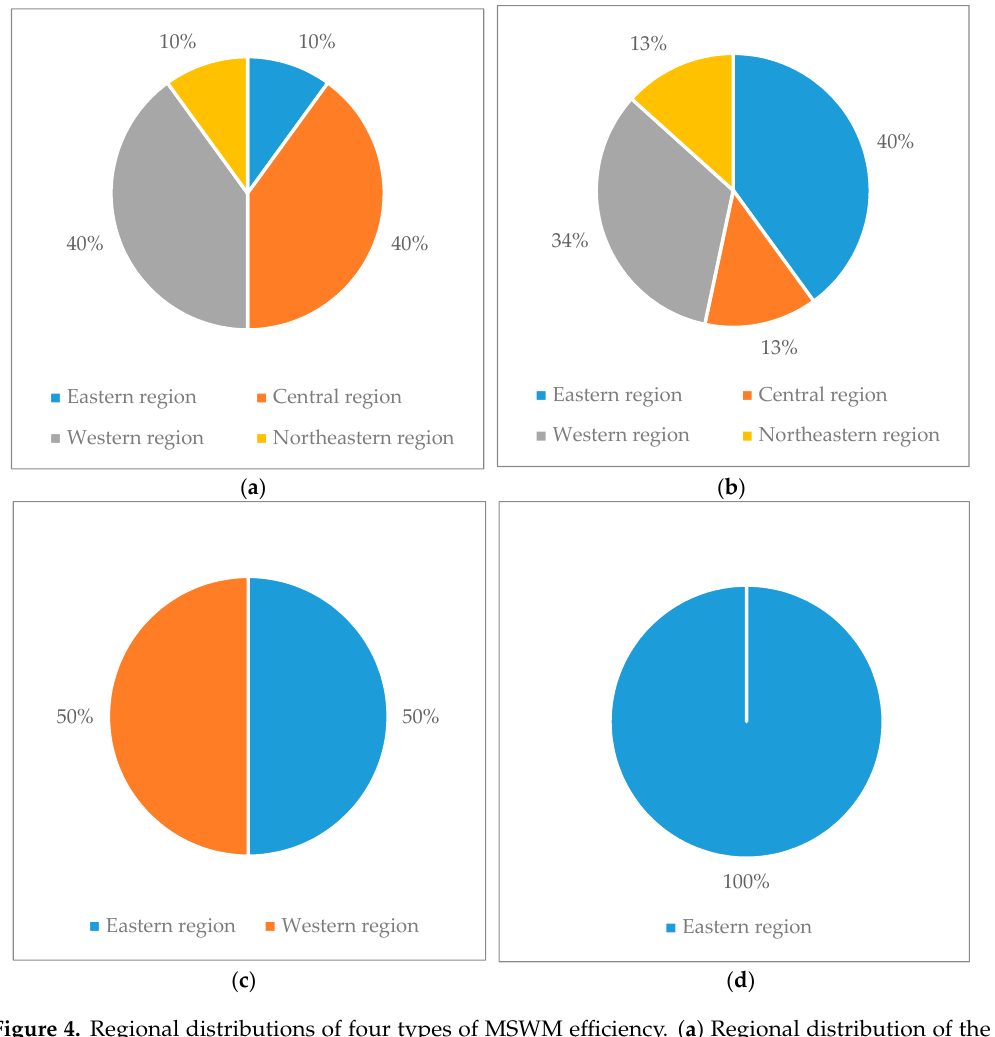
Figure 4. Regional distributions of four types of MSWM efficiency. ( a ) Regional distribution of the first type of MSWM efficiency; ( b ) Regional distribution of the second type of MSWM efficiency; ( c ) Regional distribution of the third type of MSWM efficiency; ( d ) Regional distribution of the fourth type of MSWM efficiency.